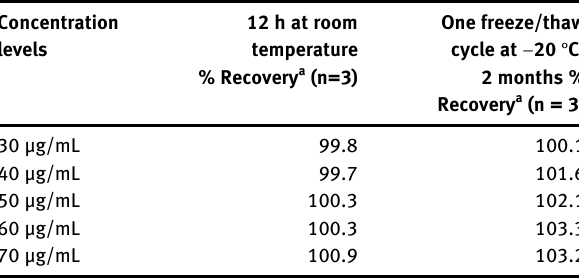
Table  : Stability of midazolam processed samples at room tem- perature and after one freeze/thaw